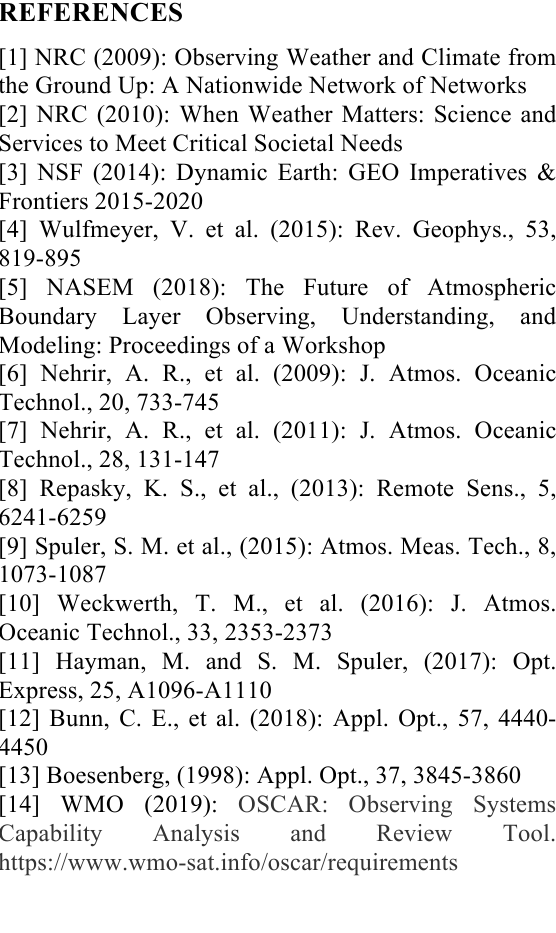
Figure 4: Comparisons of DIAL temperature data with DIA radiosonde launces. The red dashed lines are 3 o C bounds and the dotted lines are 1 o